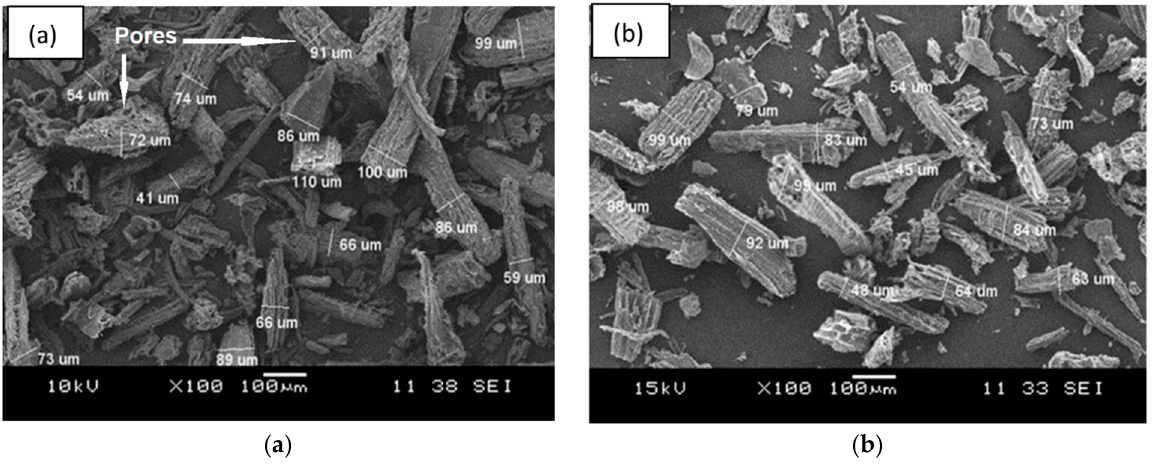
Figure 1. The SEM micrographs of filler ( a ) CWF and ( b ) CWF-ZnCl 2 .